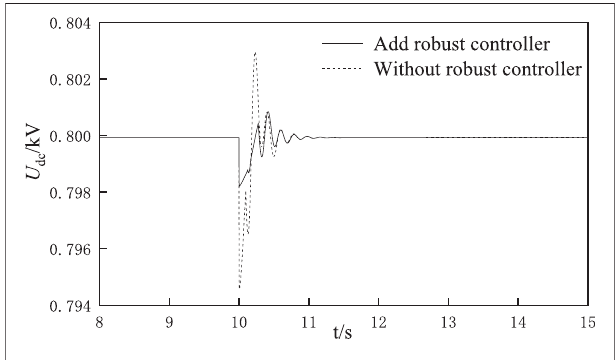
FIGURE 13 | DC bus voltage waveform when chopper K ii is